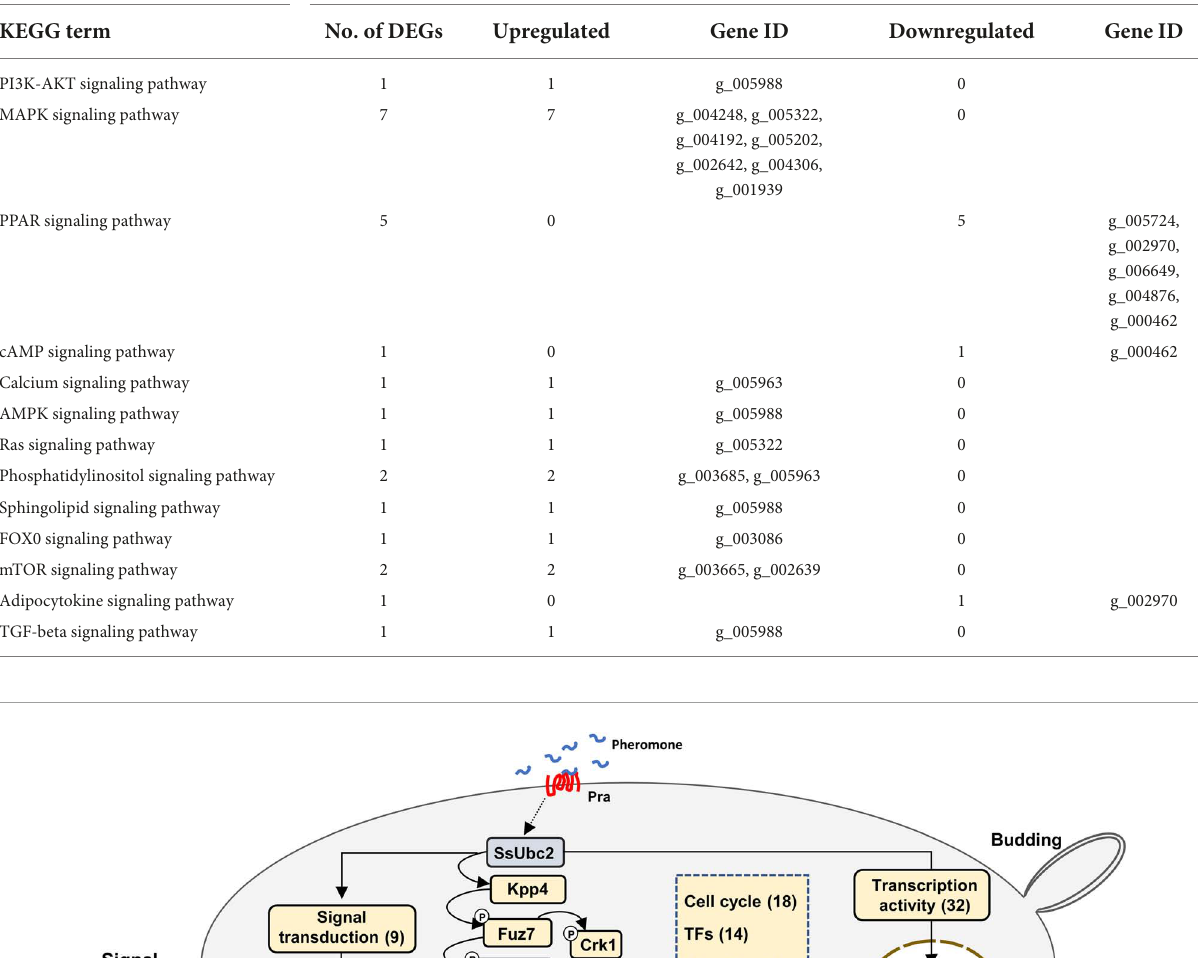
TABLE 3 Signaling-involved DEGs that do not respond to mating in Ssubc2 -null mutants. Function Shared only by WT × WT and WT × (cid:49)